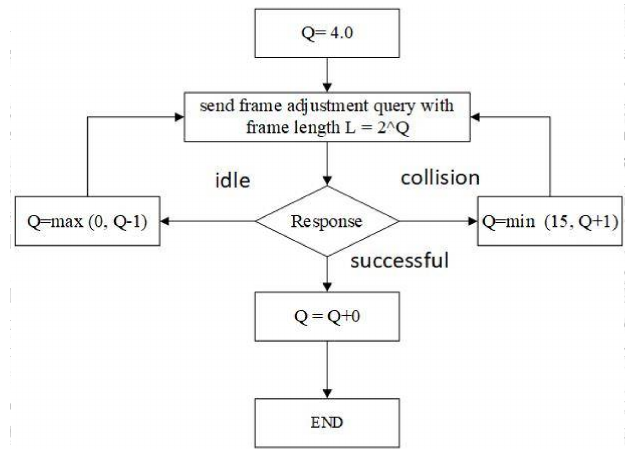
Figure 2. Dynamic frame adjustment in the proposed algorithm.